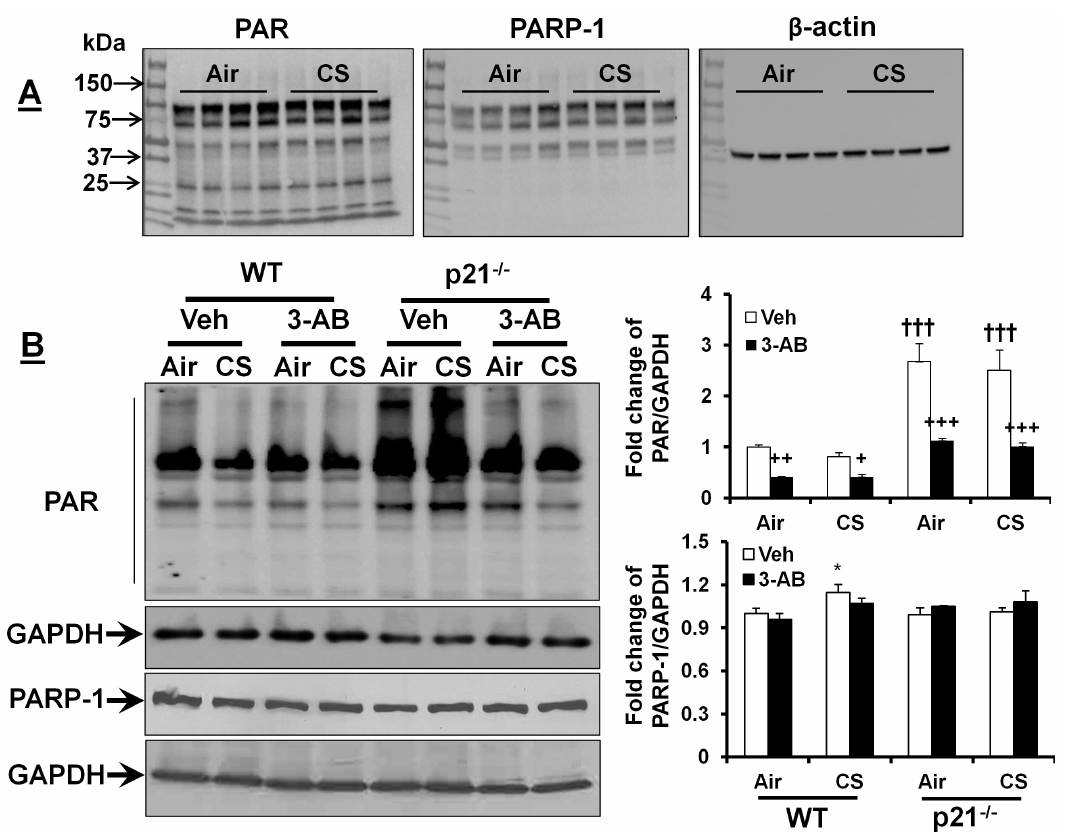
Figure 3. p21 deletion increased the levels of PAR, which was reduced by 3-AB treatment. The levels of PAR and PARP-1 were determined by Western blot in lungs of C57BL/6J ( A ), and p21 -/- mice as well as WT littermates ( B ) in response to CS. PAR levels were increased in lungs of p21 -/- mice as compared to WT mice. 3-AB treatment reduced PAR level in lungs of both p21 -/- and WT mice. Intact PARP-1 level was not altered by either p21 deficiency or 3-AB treatment. Gel pictures shown are representative of at least 3 separate mice. Fold change is indicative of the alteration of PAR and PARP-1 compared with air-exposed and vehicle (Veh)-treated WT mice after normalizing to corresponding GAPDH or b -actin. Data are shown as mean 6 SEM (n=3-13 per group). * P , 0.05 vs air group; + P , 0.05, ++ P , 0.01, +++ P , 0.001 vs Veh group; {{{ P , 0.001 vs WT mice.